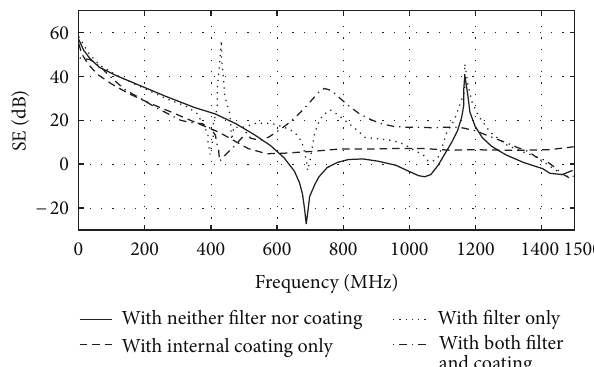
F 20: Shielding effectiveness versus frequency at the center of a by a plane wave at normal incidence.